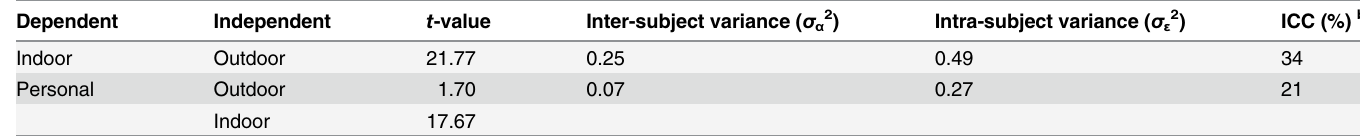
Table 2. Mix model analyses of inter- and intra-subject variances of each dependent airborne pollen count a . Dependent Independent